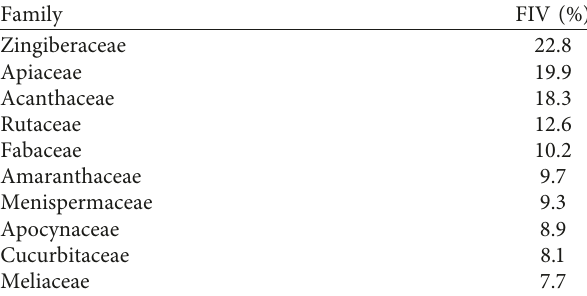
Table 2: Family importance value (FIV) of the ten plant families with the highest